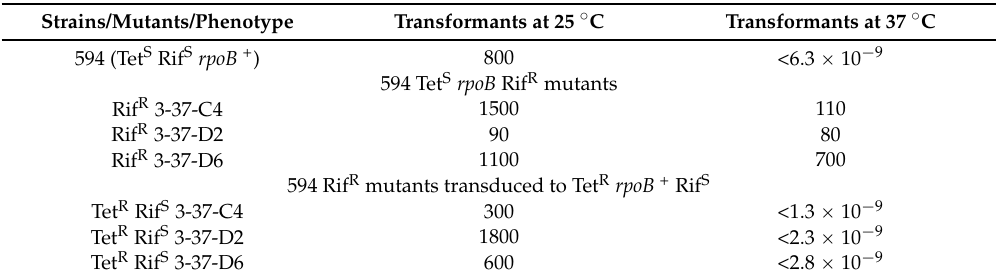
Table 7. pcIpR- P -timm ∆ rop transformation ( ˆ 10 ´ 7 ) into Tet S rpoB Rif R mutants and their transductants made Tet R rpoB + Rif S